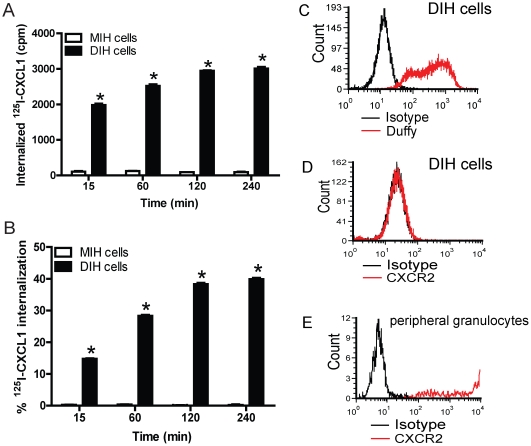
Duffy antigen mediates CXCL1 binding and endocytosis in DIH cells.MIH cells and DIH cells were incubated with 125I-CXCL1/GRO-α at the designated time points then were washed with binding buffer or acid wash buffer, as described in Materials and Methods. (A) Internalized 125I-CXCL1/GRO-α counts in MIH and DIH cells. * p<0.01 MIH cells vs DIH cells, paired t test. (B) Percentage of 125I-CXCL1/GRO-α internalization in MIH and DIH cells. * p<0.001 MIH cells vs DIH cells, paired t test. Experiments were conducted in triplicates and the mean ± SEM from two independent experiments is shown. (C) DIH cells were labeled with anti-Duffy 2C3 Fy6 antibody or isotype mouse IgG1 antibody and surface expression of Duffy examined by flow cytometry. (D) DIH cells do not show detectable surface CXCR2 expression following immune-labeling with anti-human CXCR2 or isotype mouse IgG1 antibody. (E) Peripheral leukocytes were isolated from a healthy volunteer and immune-labeled with anti-human CXCR2 or isotype IgG1 control antibody. Histogram shows gated population of granulocytes expressing CXCR2. Flow cytometric examination of surface DARC and CXCR2 expression on DIH cells was performed 2 independent times. CXCR2 expression on human peripheral granulocytes was performed once.